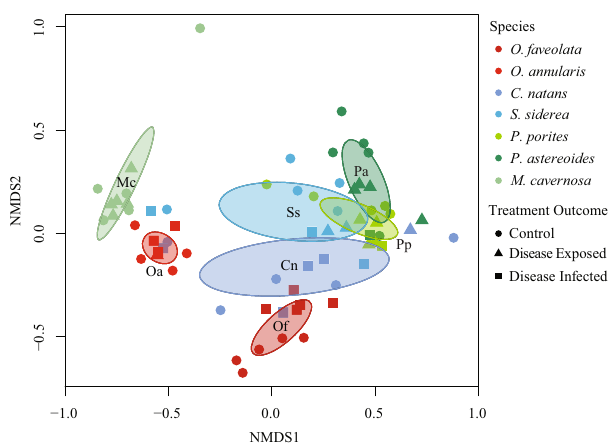
Fig. 5 NMDS of Bacterial Communities. Non-metric multidimensional scaling (NMDS) (Stress = 0.13) of bacterial communities from the tissue of the seven species tested organized by species and treatment outcome (control, disease-exposed, disease-infected). Ovals represent 95% con fi dence intervals. Table 1 Dysbiosis. Species Disease-exposed vs. control